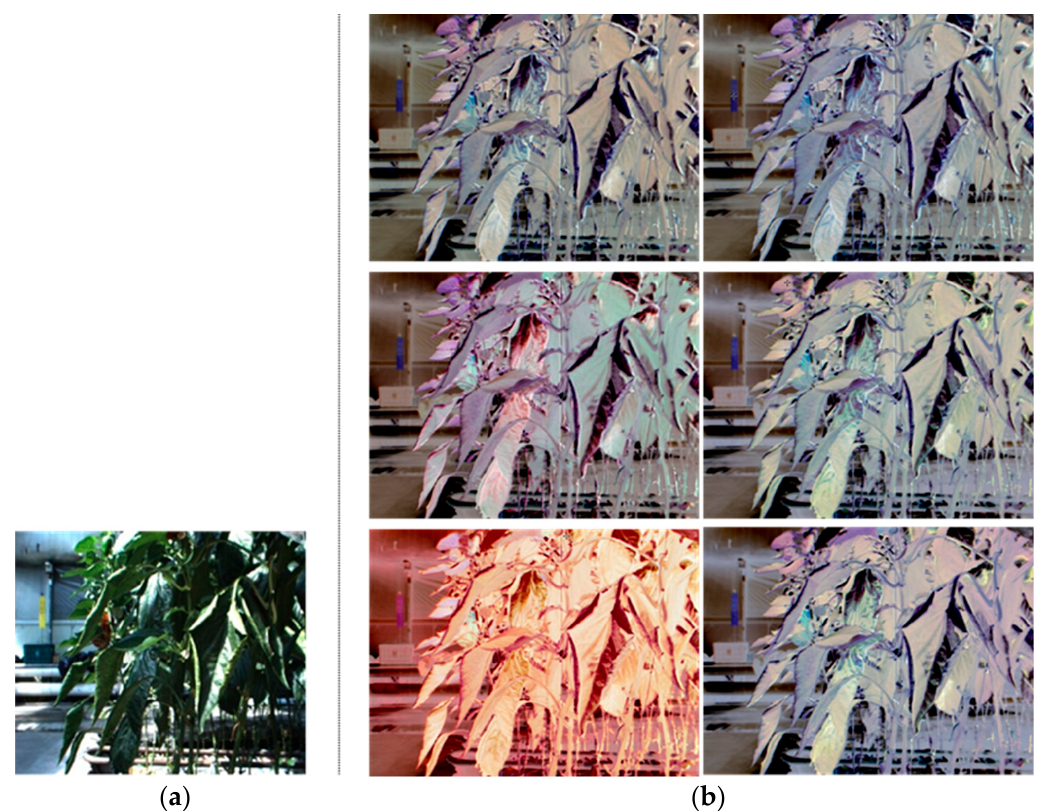
Figure 7. Reference image for PSNR comparison ( a ) and PSNR images by difference of wavelength ( b ).